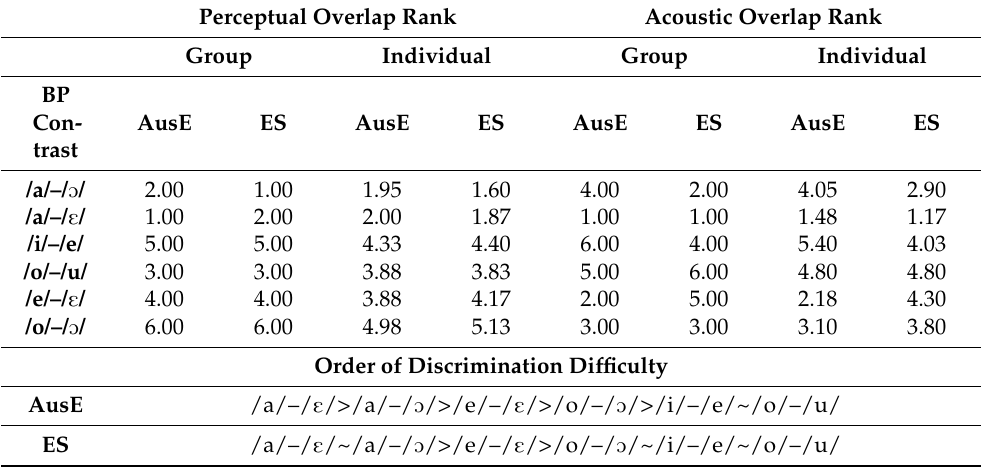
Table 7. Ranking of the 6 BP contrasts according to perceptual and acoustic overlap scores. Individual overlap rankings represent the mean rank across participants. In order to compare the overlap scores to the actual discrimination results, we provide the order of discrimination difficulty (bottom two rows) from the group discrimination results across the six BP contrasts reported from the previous page. Perceptual Overlap Rank Acoustic Overlap Rank Group Individual Group